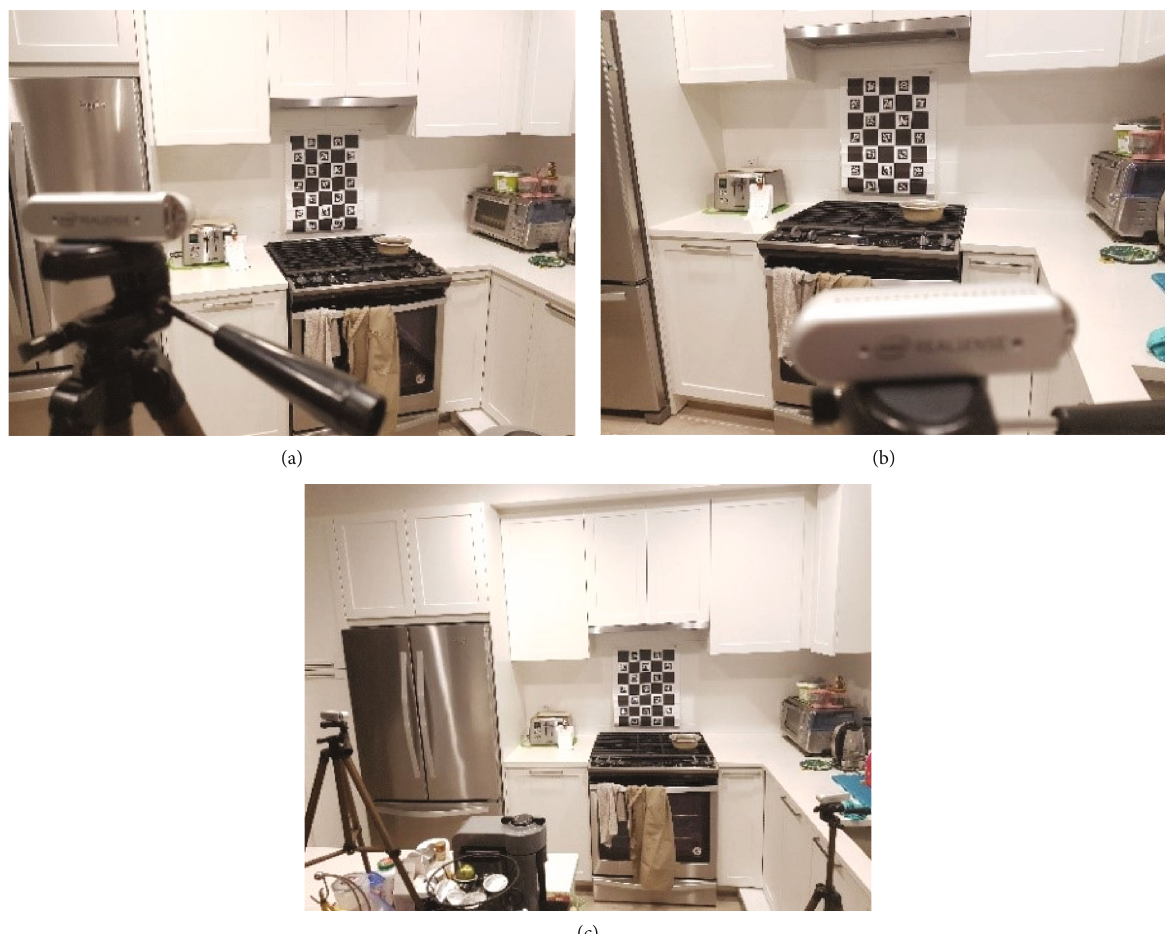
Figure 10: Example of sensor setup for the fourth case study including an oven, a cooking bowl, a toaster, and a microwave oven. (a, b) show views including the left and right sensors. (c) shows the full view of the monitoring area including the locations of the left and right